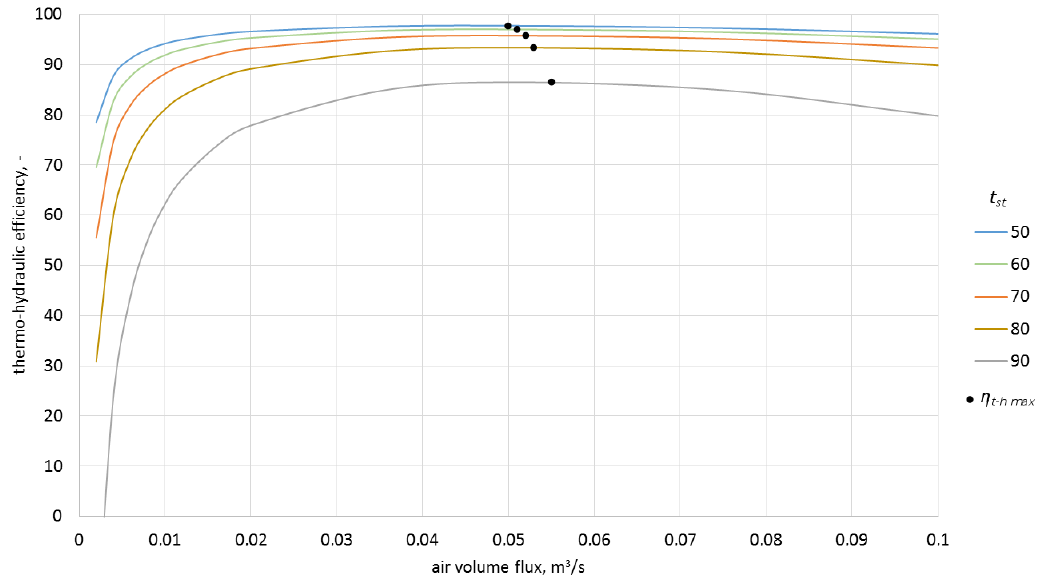
Figure 11. Thermo-hydraulic efficiency for the inlet temperature of 100 °C and various ceramic brick temperatures.